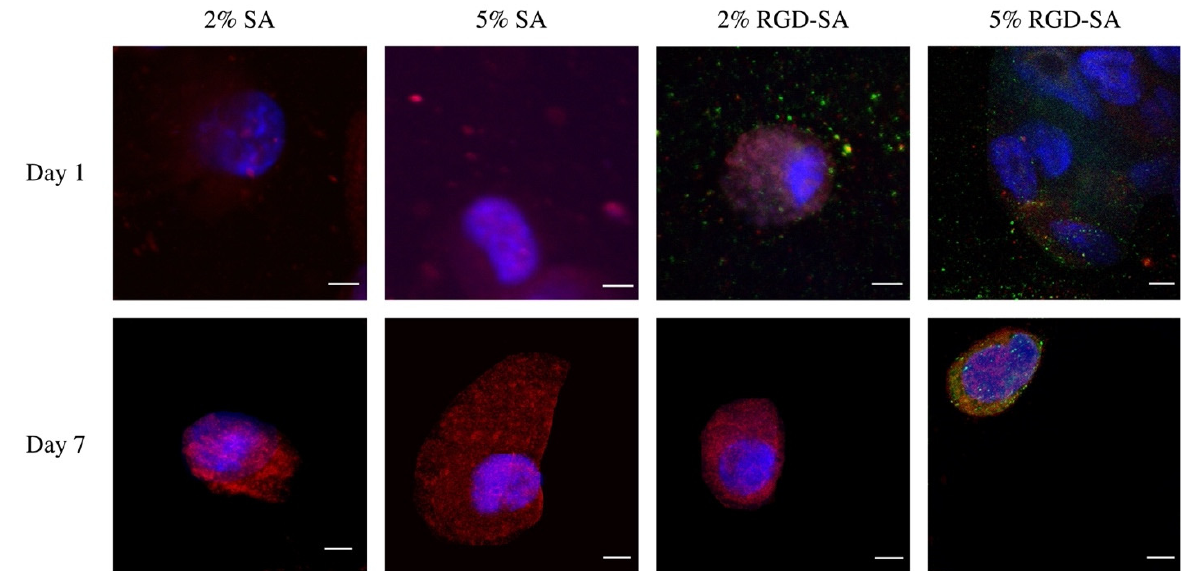
Figure 5. Cell morphology 1 and 7 days after bioprinting in alginates. Cells appeared similar in appearance 1 day after bioprinting, but only RGD-modified alginates (RGd-SAs) showed integrin signals. However, 7 days after bioprinting, only cells printed in 5% RGD-SA demonstrated integrin signals with clustering. Cell morphologies were otherwise similar in different alginates 7 days after bioprinting. SA: sodium alginate. Scale bar = 5 µm.